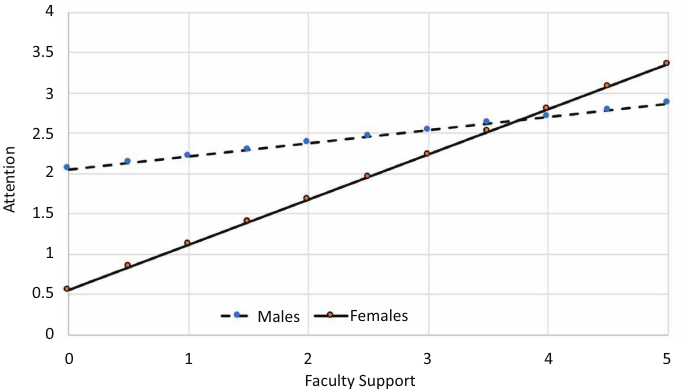
Figure 1. Interactions between gender and faculty